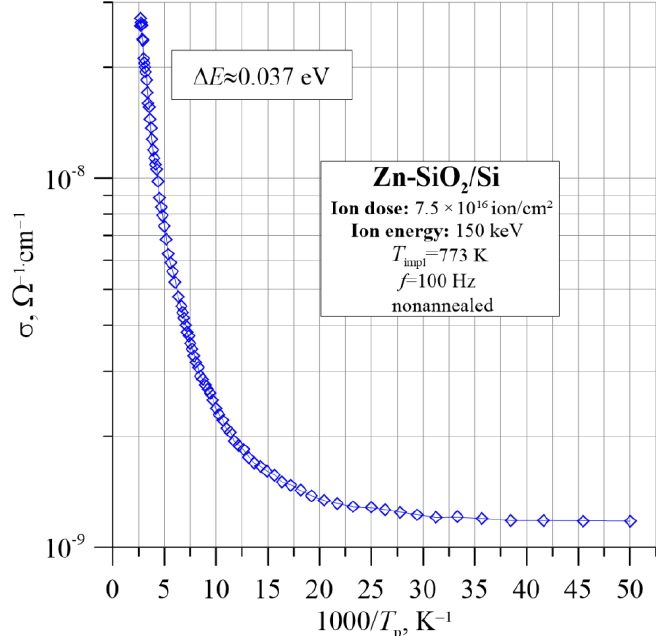
Figure 4. The Arrhenius dependence of the conductivity σ for the Zn-SiO 2 /Si nanocomposite imme- diately after preparation under “ hot ” implantation conditions (150 keV, 7.5 × 10 16 ion/cm 2 , immediately after preparation under “hot” implantation conditions (150 keV, 7.5 × 10 16 ion/cm 2 , T impl = 773 K). T impl = 773